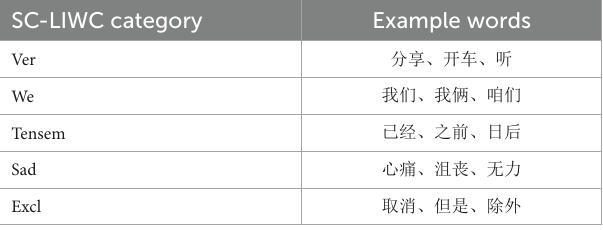
TABLE 5 Comparison of the reliability results of the four models.